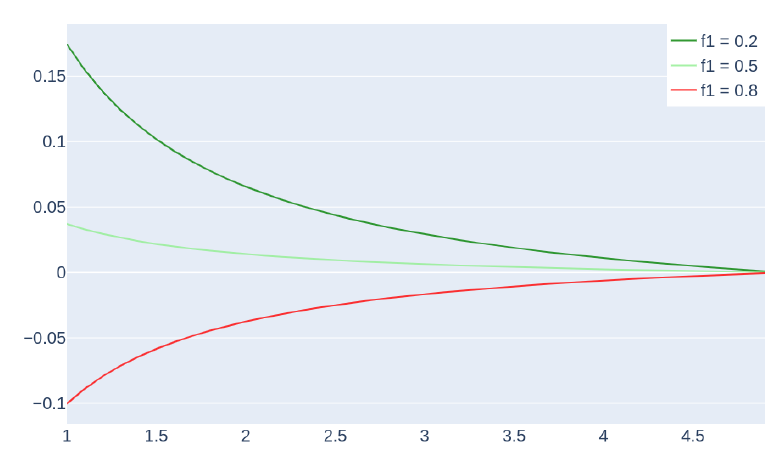
Figure 5. Fuel consumption saving (l) vs. slope angle α 2 ( ◦ ) of path (2). The saving is computed by the difference in the consumption of path (1) (with fixed α 1 = 5 ◦ ) to path (2) of Figure 4. The curves in the colors are for different values of f 1 ∈ [ 0.2,0.5,0.8 ] (L/km) ( fuel_per_km consumption in path p 1